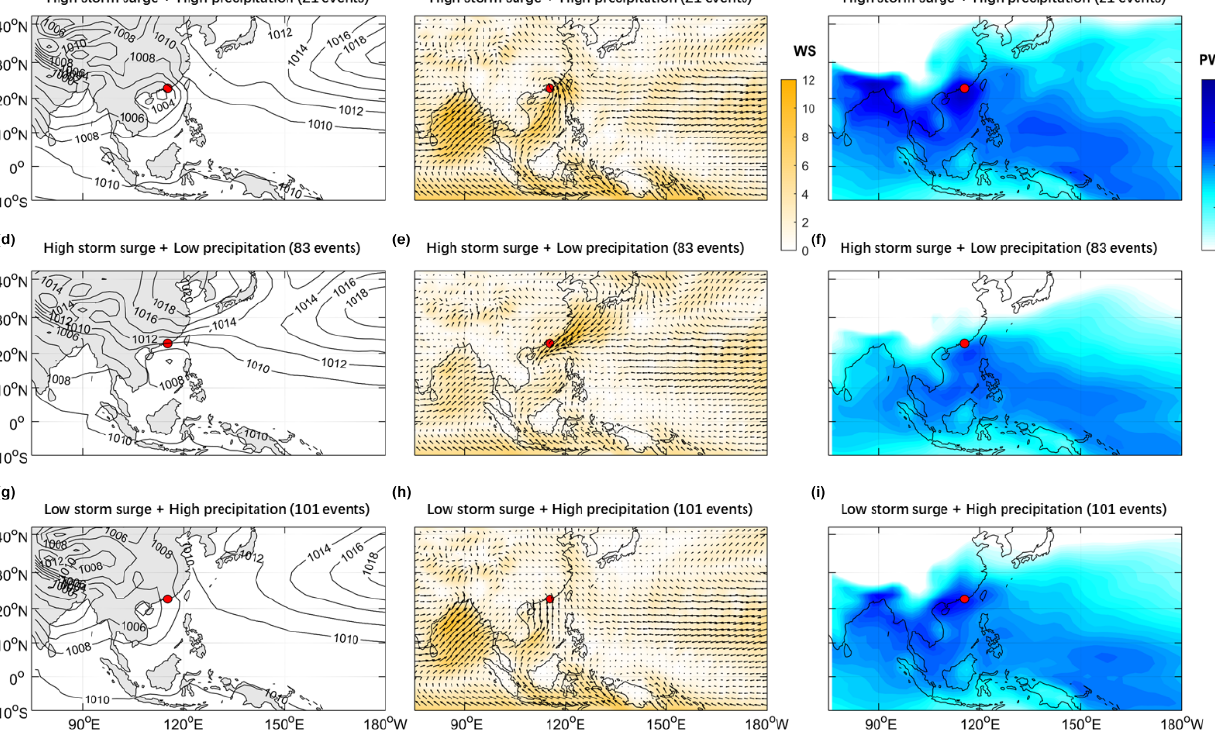
Figure 8. Meteorology conditions for Shanwei (TG6): (a, d, g) sea-level pressure (mbar), (b, e, h) wind speed (ms − 1 ) and direction (grey arrows), and (c, f, i) precipitable water content (kgm − 2 ) during (a–c) joint occurrence events with high storm surge and high precipitation (Zone 1), (d–f) for events with high storm surge and low precipitation (Zone 3), and (g–i) events with low storm surge and high precipitation (Zone